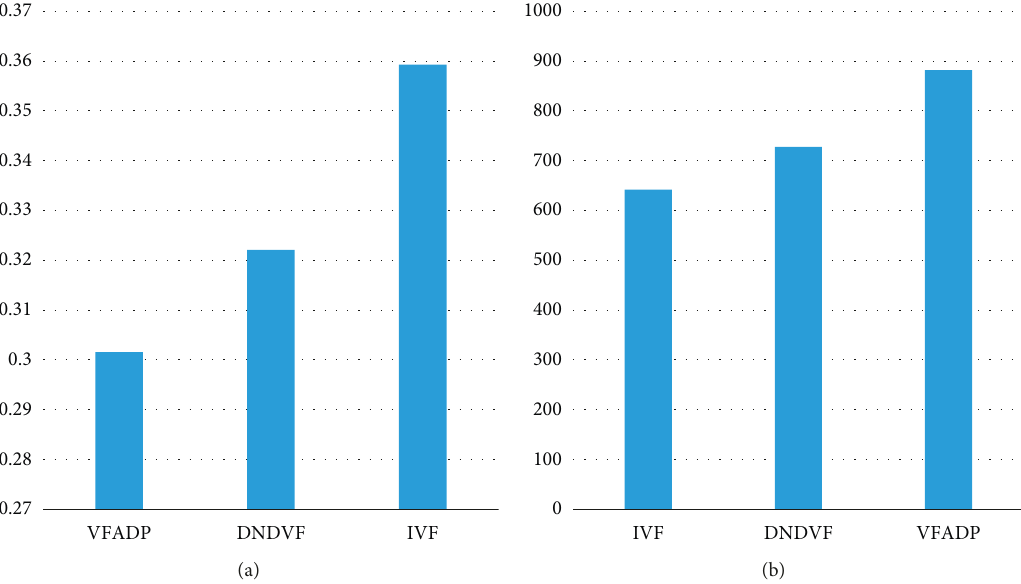
Figure 4: Coverage effect and moving distance in different algorithms when N � 40. (a) Coverage effect. (b) Moving distance (m). 0.470.480.490.50.510.520.53